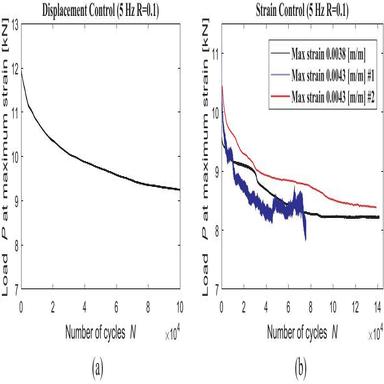
(a) Evolution of the load at maximum displacement during a fatigue test in displacement control; (b) evolution of the load at maximum strain in fatigue tests run in strain control.